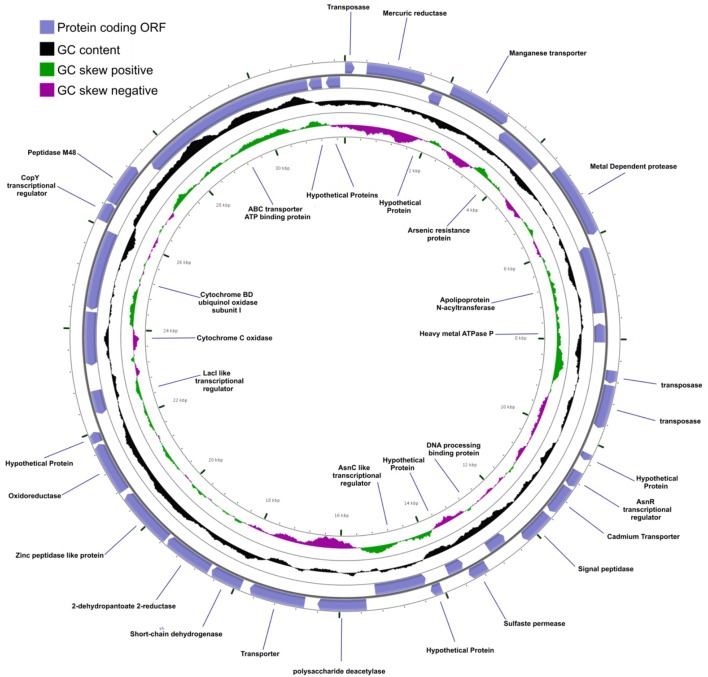
Agrococcus pavilionensis strain RW1 LC-RRW783 plasmid genomic plot. The blue lines are for the name of the predicted protein-coding open reading frame.